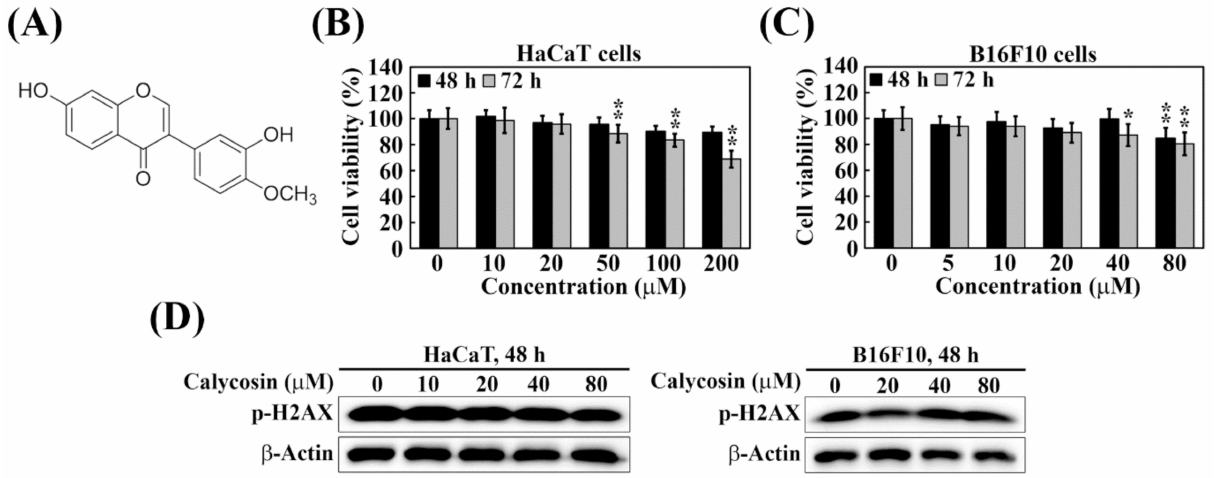
Figure 1. Cytotoxicity of calycosin in HaCaT and B16F10 cells. ( A ) Chemical structure of calycosin. ( B ) Human keratinocyte HaCaT cells and ( C ) mouse melanoma B16F10 cells were treated with indicated concentrations of calycosin for 48 and 72 h. Cell viability was analyzed by MTT assay. Data are represented as the means ± S.D. from three independent experiments. Significant difference versus control: * p < 0.05, ** p < 0.01. ( D ) Western blotting analysis of p-H2AX expression in HaCaT (left) and B16F10 (right) cells treated with indicated concentrations of calycosin for 48